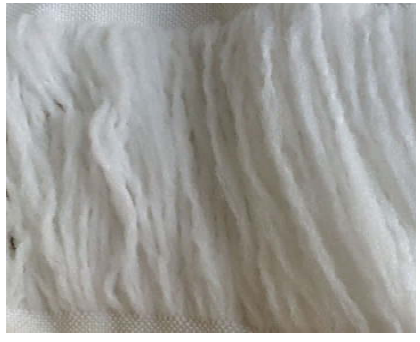
Figure 3. The appearance of biological carrier. Table 2. The technical parameters of biological carriers.